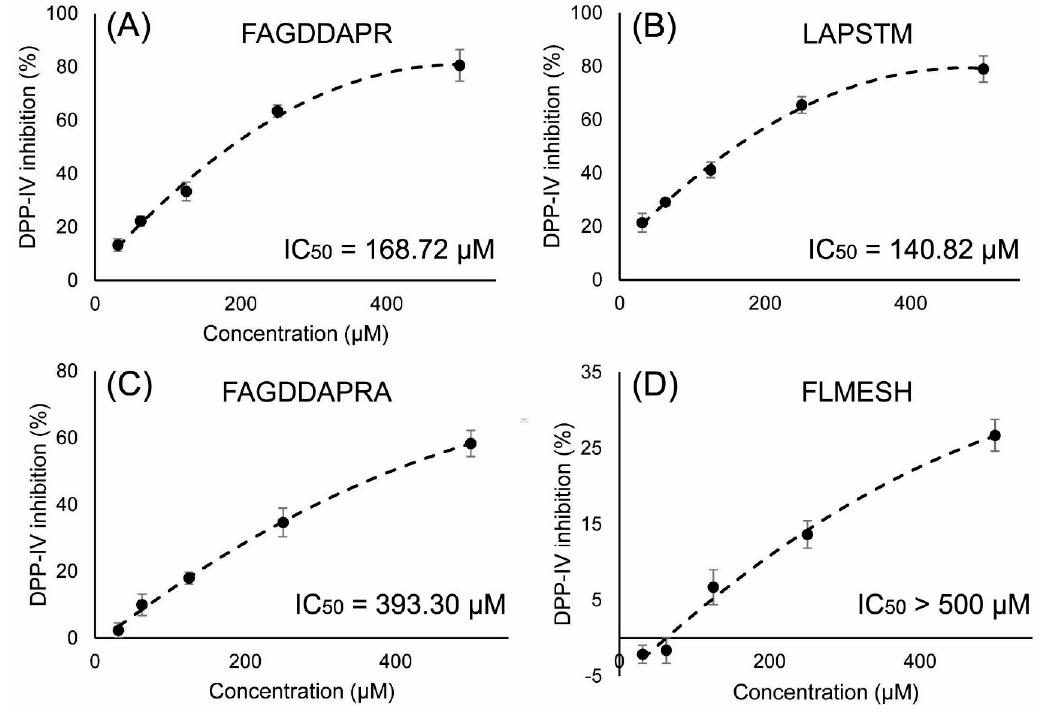
Figure 6. DPP-IV inhibitory activity of the four peptides: ( A ) FAGDDAPR; ( B ) LAPSTM; ( C ) FAGDDAPRA; and ( D ) FLMESH.